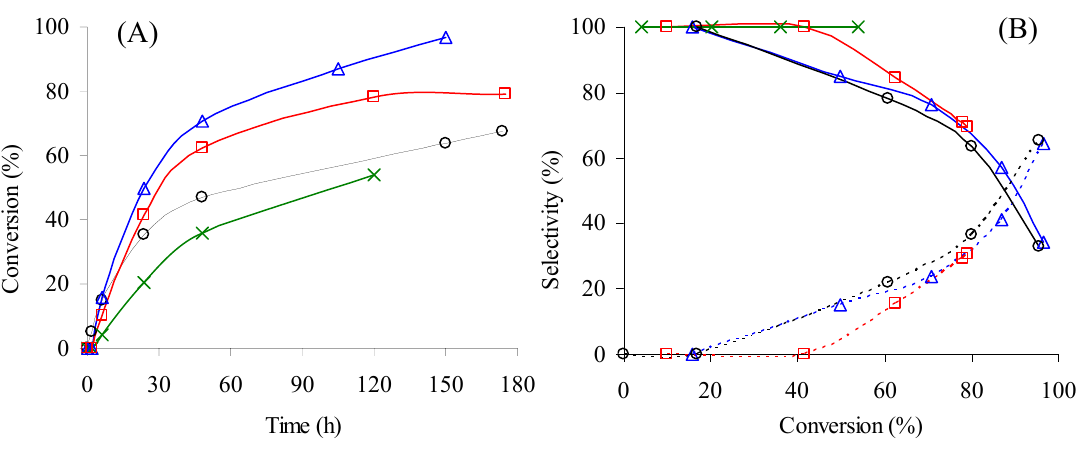
Figure 5. (A) - Ethylbenzene oxidation with t-BuOOH, at 70 ºC, using acetonitrile as solvent, in the presence of CeNR ( O ), CeNR calcined at 280 ºC ( (cid:175) ),CeNR pre-treated with H O ( (cid:133) ) or t -BuOOH ( (cid:85) ). (B) - Dependence of selectivity to PhEtOOT (solid lines) and 2 2 acetophenone (dashed lines) on conversion for the reactions conditions indicated in (A) - the same symbols were used for each